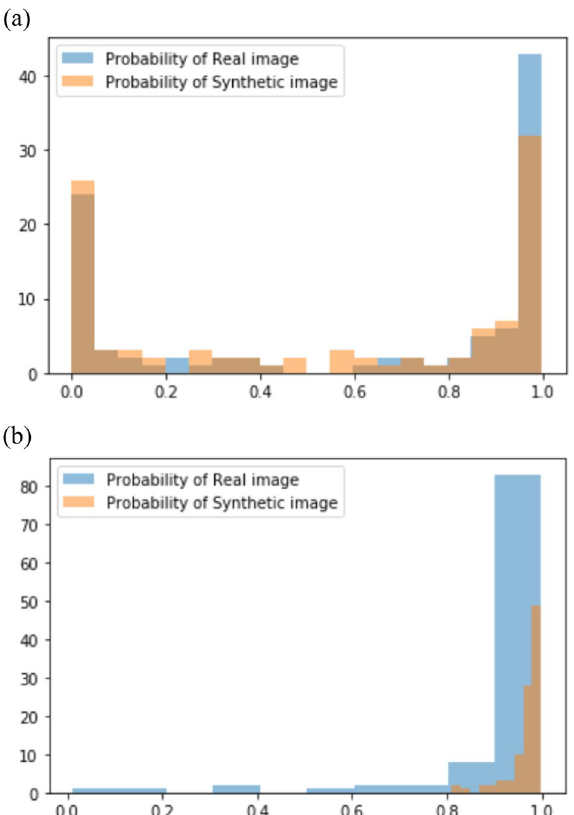
Figure 2. Probability scores of the CNN classifier in Turing test datasets. ( a ) First image Turing test dataset. ( b ) Second image Turing test